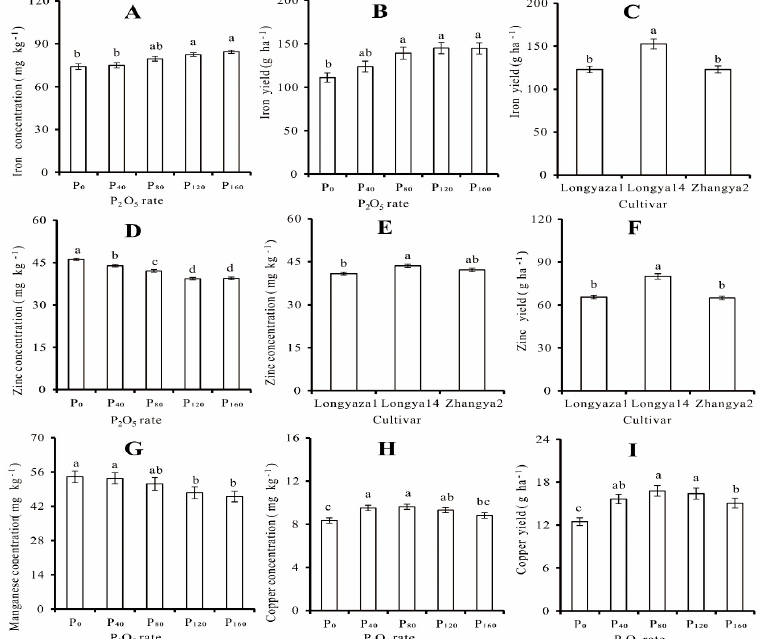
Figure 4. Effects of ( A ) phosphorus level and cultivar on iron concentration and ( B ) yield, ( C ) cultivar on iron yield, ( D ) phosphorus level on zinc concentration, ( E ) cultivar on zinc concentration and ( F ) yield, and phosphorus level on ( G ) manganese concentration, ( H ) copper concentration, and ( I ) copper yield. Error bars are standard errors of the means ± SE ( n = 15). Di ff erent letters indicate means that are signi fi cantly di ff erent at P < 0.05 according to the Tukey test.